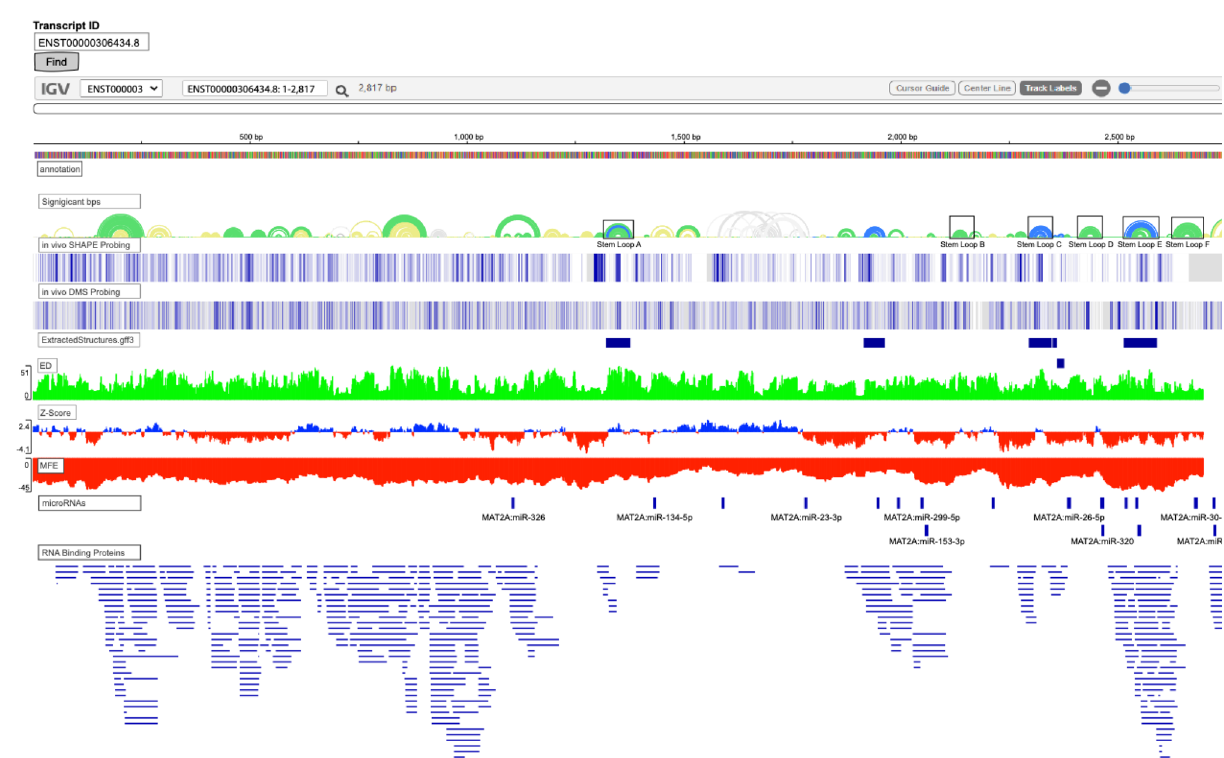
Figure 3. Example of the MAT2A transcript (ENST00000306434.8) data populated in the updated RNAStructuromeDB IGV window. From top to bottom the tracks have been organized into the annotation or sequence, significant bps or arc diagram, extracted structures with z-scores ≤ −2, ensemble diversity (ED), z-score, and MFE or ΔG. Additional in vivo DMS and SHAPE biochemical probing data (displayed as a heat map), microRNA sites, and RNA binding protein sites were generated and added to the window after ScanFold data acquisition. All track colors except significant bps were changed from their default color of gray to green for ED, blue for positive z-score, red for negative z-score, and red for MFE. The Rfam stem loop A-F structures of the 3 ′ UTR have been annotated by boxed regions for ease of